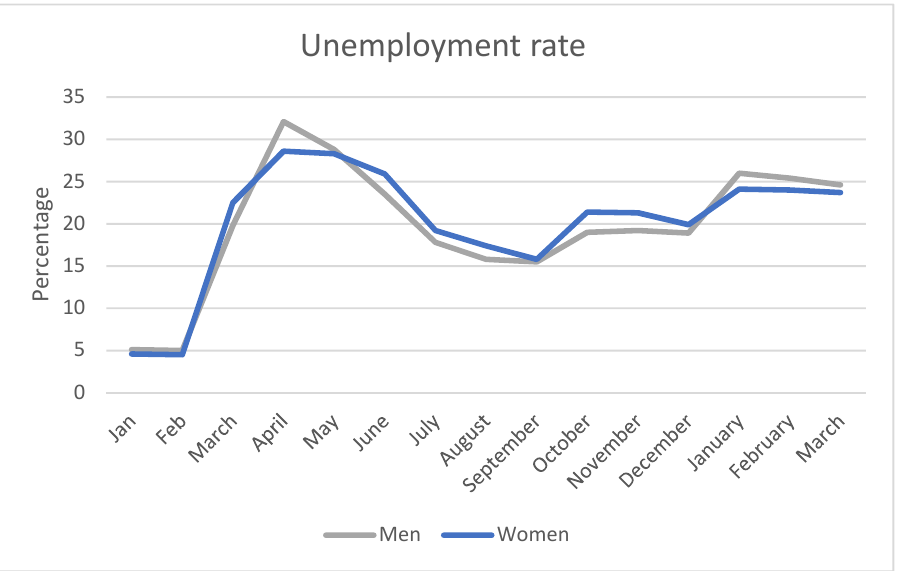
Figure 1. The unemployment rate of those aged 15–74 in Ireland between January 2020 and March 2021. Source: Central Statistics Office.